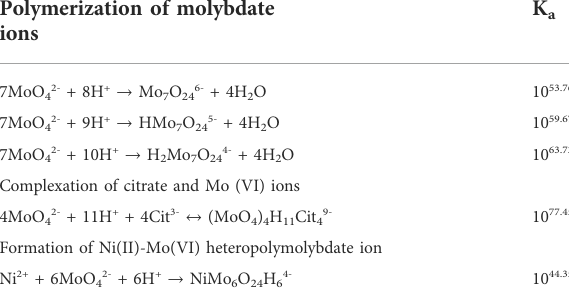
TABLE 2 Equilibrium constant of polymerization of molybdate ions, complexation ofcitrateandMo (IV)ion,andreaction ofNi andMo (IV) ions (Murase et al., 2000; Murase et al., 2004). Polymerization of molybdate